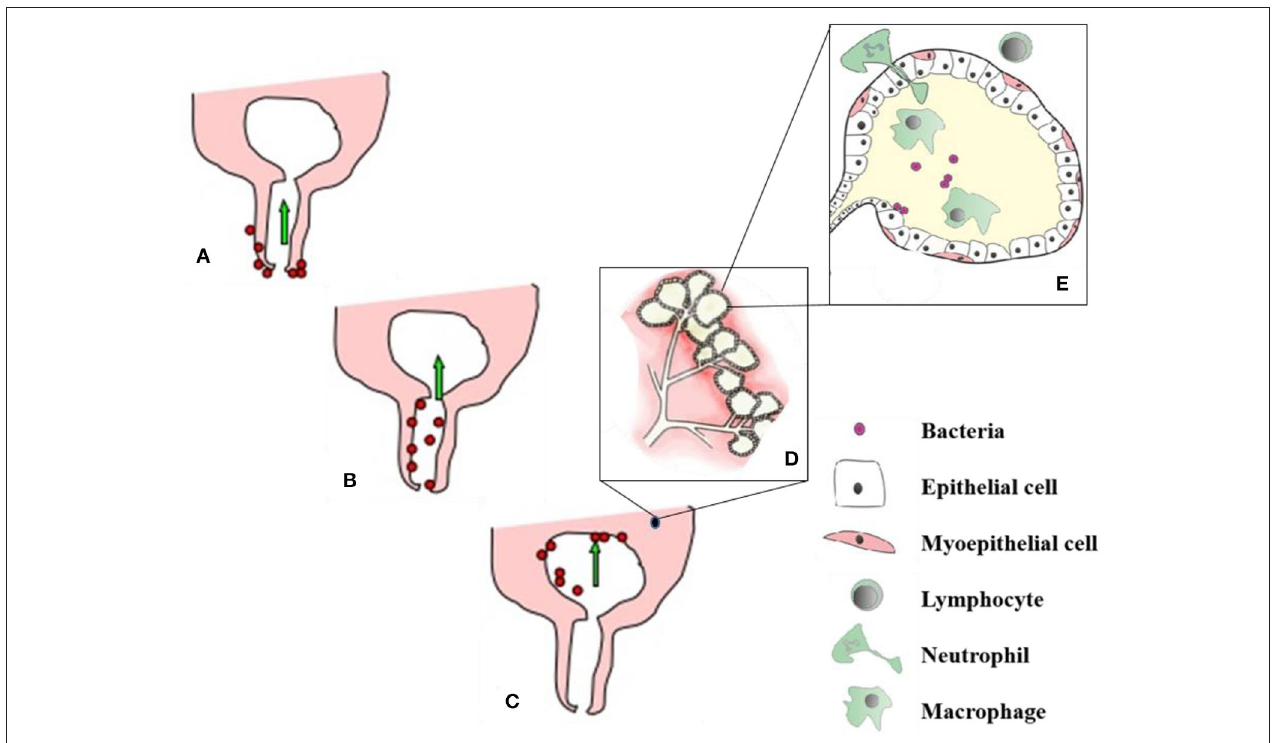
FIGURE 2 | Process of udder infection. (A) – Organisms invade the udder through teat canal, (B,C) - Migrate up the teat canal and colonize all parts where the milk gets and finally setup the infection in mammary gland, (D) - alveoli and secretory mammary epithelial cells. After getting bacterial infection, cellular defense mechanism become active and phagocytic cells (from blood) effort to engulf and kill the bacteria, phagocytosis by products and release of bacterial toxins damage to the secretory mammary epithelial cells (E) . Soure: Adapted from Sharma and Jeong